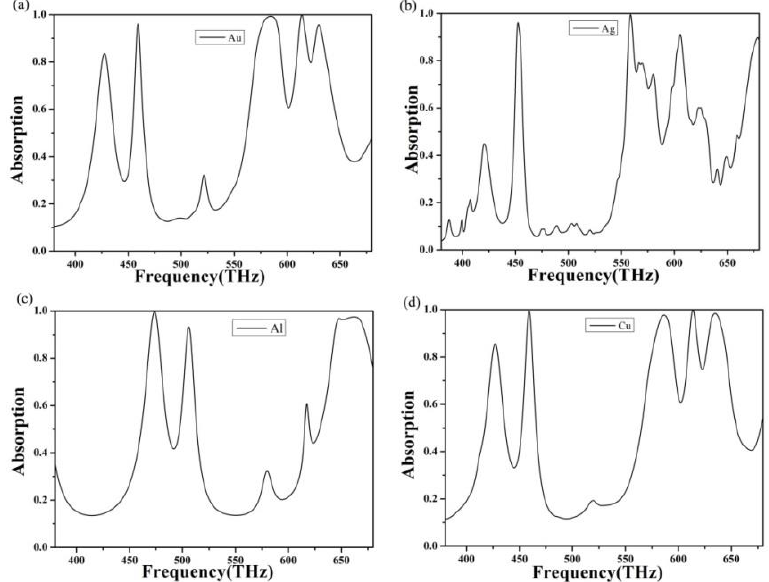
Figure 7. Change in the absorption spectrum of the absorber metamaterial. ( a ) The absorption curve when the material is gold, ( b ) the absorption curve when the material is silver, ( c ) the absorption curve is when the material is aluminum, and ( d ) the absorption curve when the material is copper.